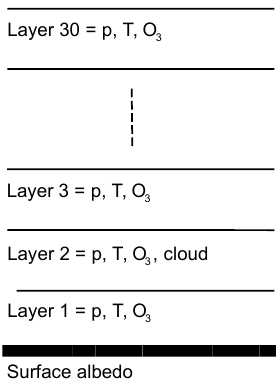
Figure 2. Schematic structure of the model